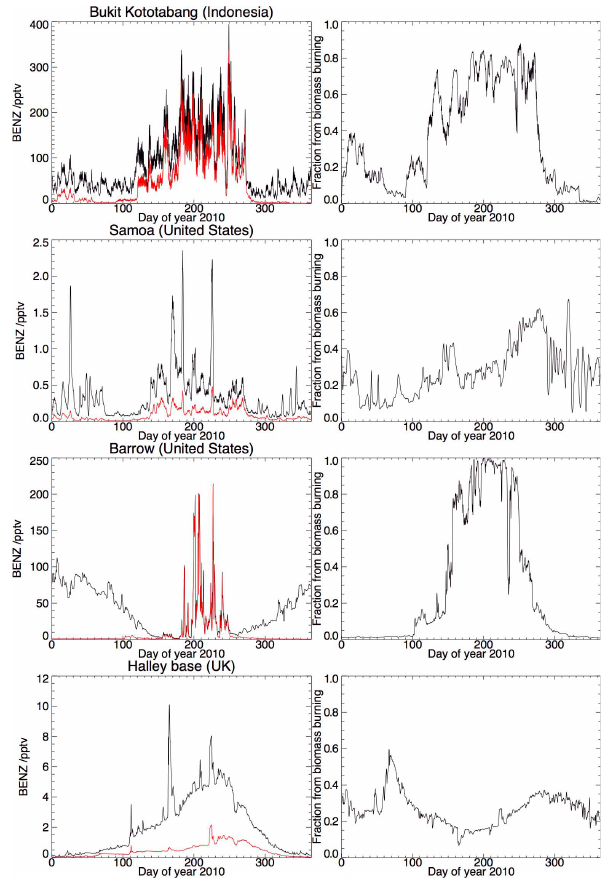
Fig. 8. Model estimates of the biomass burning inputs to benzene at four GAW observatories currently without NMHC online mea- surements. From top: Bukit Kototabang, Indonesia; Samoa, Pacific; Halley, Antarctica; Barrow, Arctic. Left figures show estimated mixing ratios (black) and biomass contribution (red). Right hand figures show % biomass